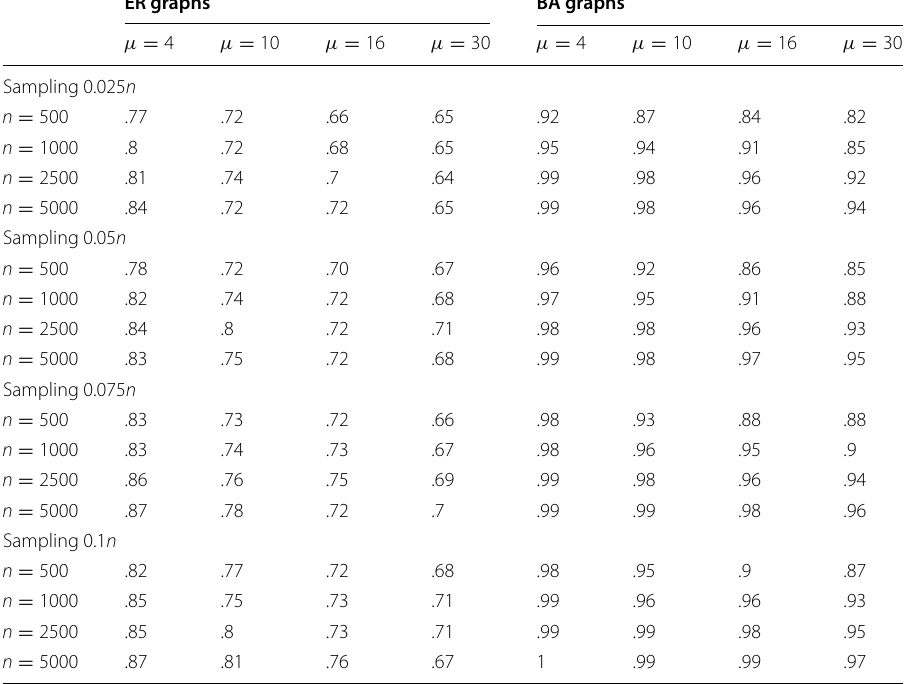
Table 1 Frequency of the max‑degree vertex being among the selected neighbors. n is the size of the graph, µ is the average degree ER